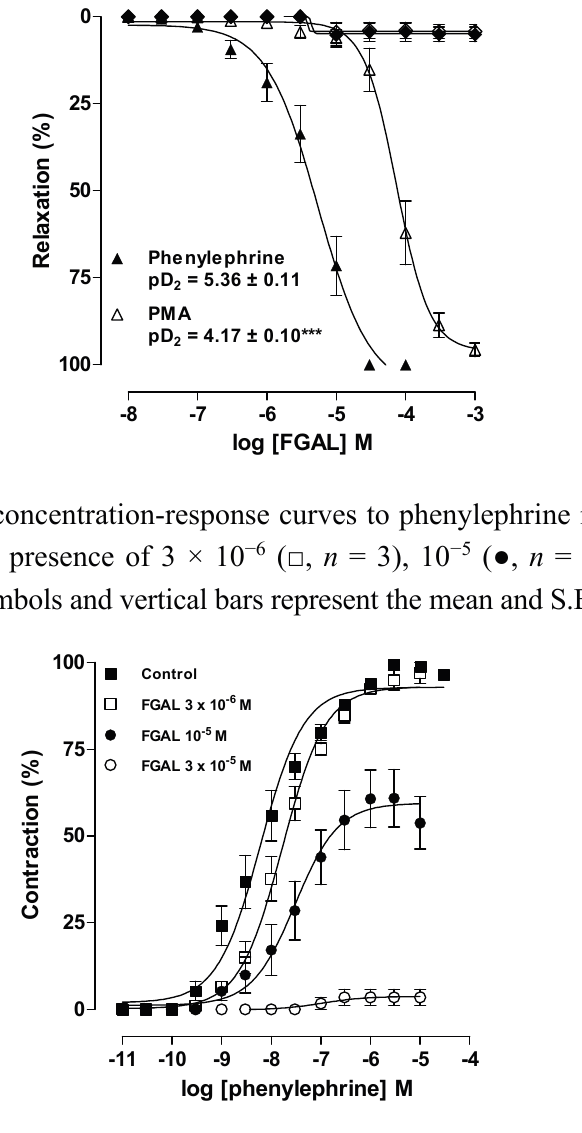
Figure 2. Effect of FGAL or vehicle on tonic contractions induced by 3 × 10 − 7 M Phe (FGAL: ▲ , n = 5; vehicle: ♦ , n = 3) or 10 − 6 M PMA (FGAL: Δ , n = 5; vehicle: ◊ , n = 3) in rat aorta. Symbols and vertical bars represent the mean ± S.E.M., respectively.